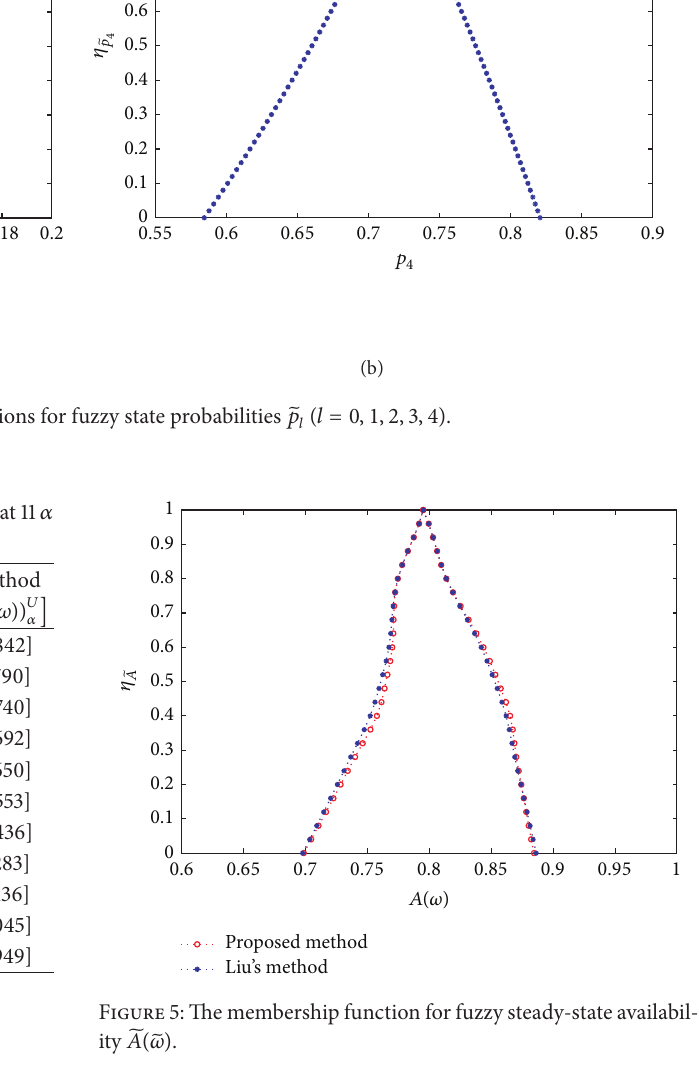
Figure 5: The membership function for fuzzy steady-state availabil- ̃𝐴(̃𝜔) ity